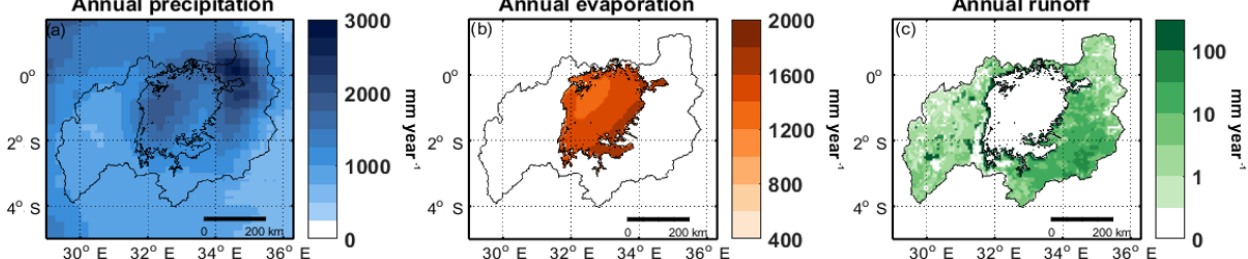
Figure 4. Climatology from 1993 to 2014: annual precipitation derived from PERSIANN-CDR observations (a) , evaporation from COSMO- CLM 2 model output (b) and runoff calculated with the CN method based on PERSIANN-CDR precipitation observations (c) .